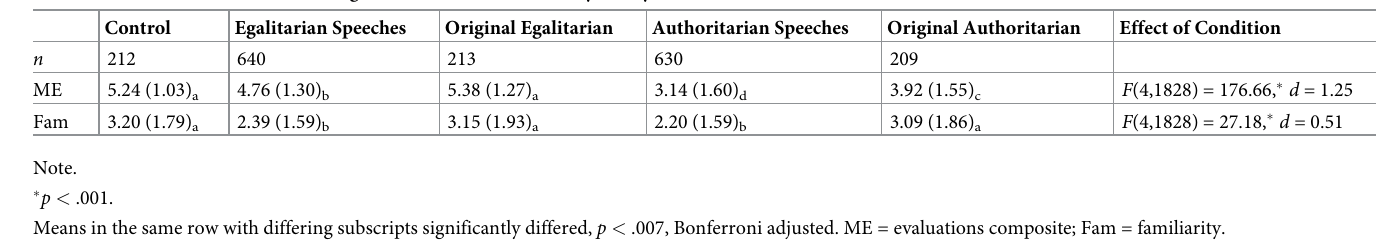
Table 2. Effects of condition on message evaluations and familiarity, Study